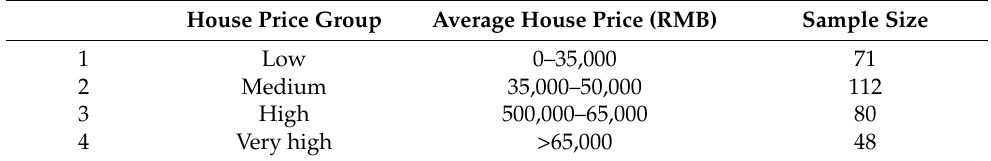
Table 3. Sample house price